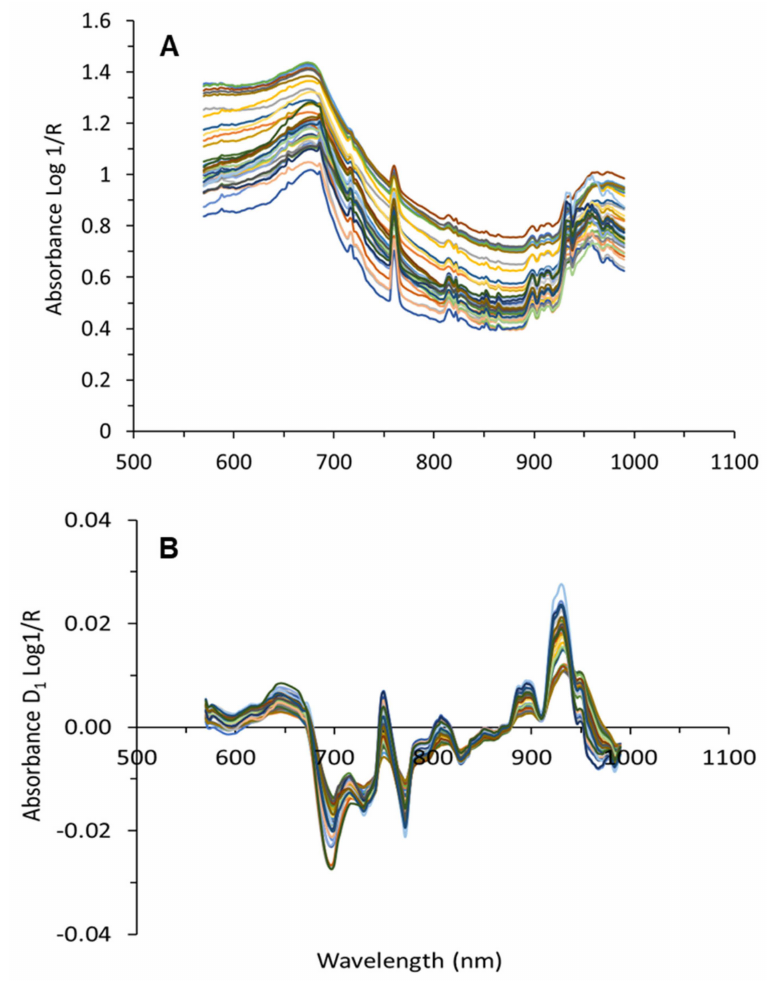
Figure 7. Average raw ( A ), and processed with Savitzky–Golay smoothing filtering (1st derivative, window size 15) ( B ) spectra collected on-the-go from grape